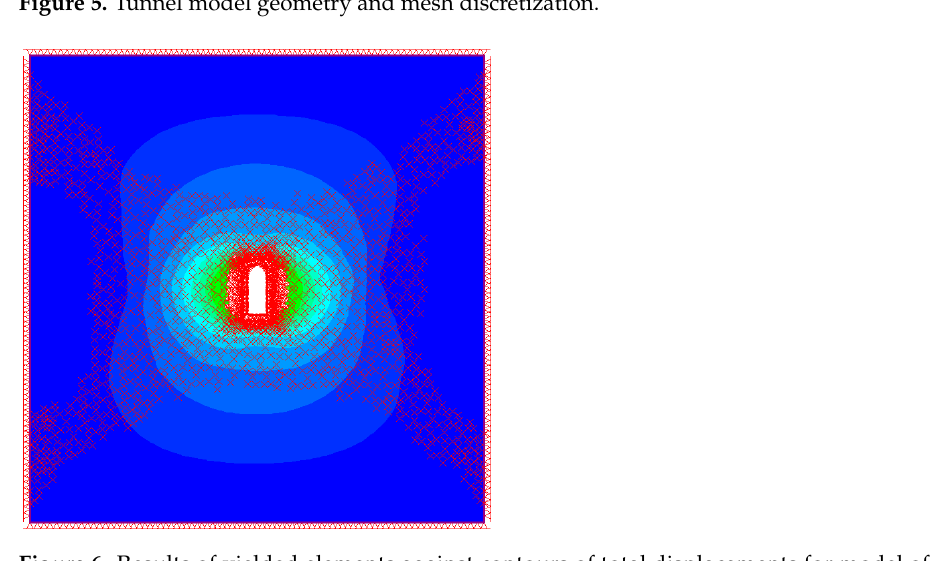
Figure 6. Results of yielded elements against contours of total displacements for model of tunnel with no